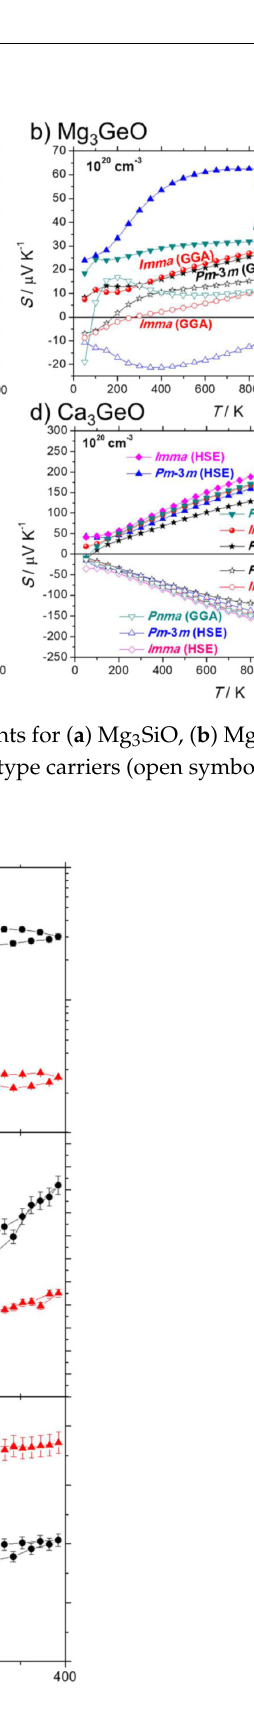
Figure 9. Experimental measurements of ( a ) electrical resistivity, ( b ) Seebeck coefficient, and ( c ) thermal conductivity for orthorhombic Ca 3 SiO and Ca 3 GeO. Reproduced from [100], © 2019, the authors.